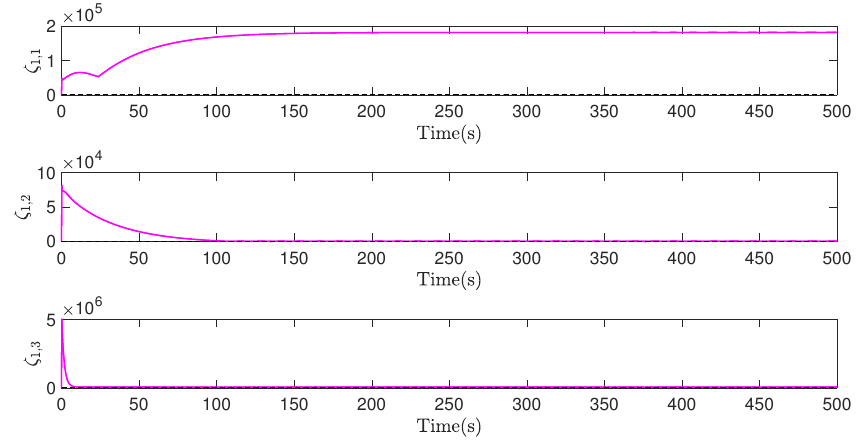
Figure 9. ζ 1 , outputs of saturation compensator of airship A 1 , in former 500 s. Moreover, some statistical analysis results about the designed event-triggered mecha- nism are given in Figures 10 and 11, from which we can know that more than 90% of the triggered time is saved compared with the traditional time-triggered mechanism.